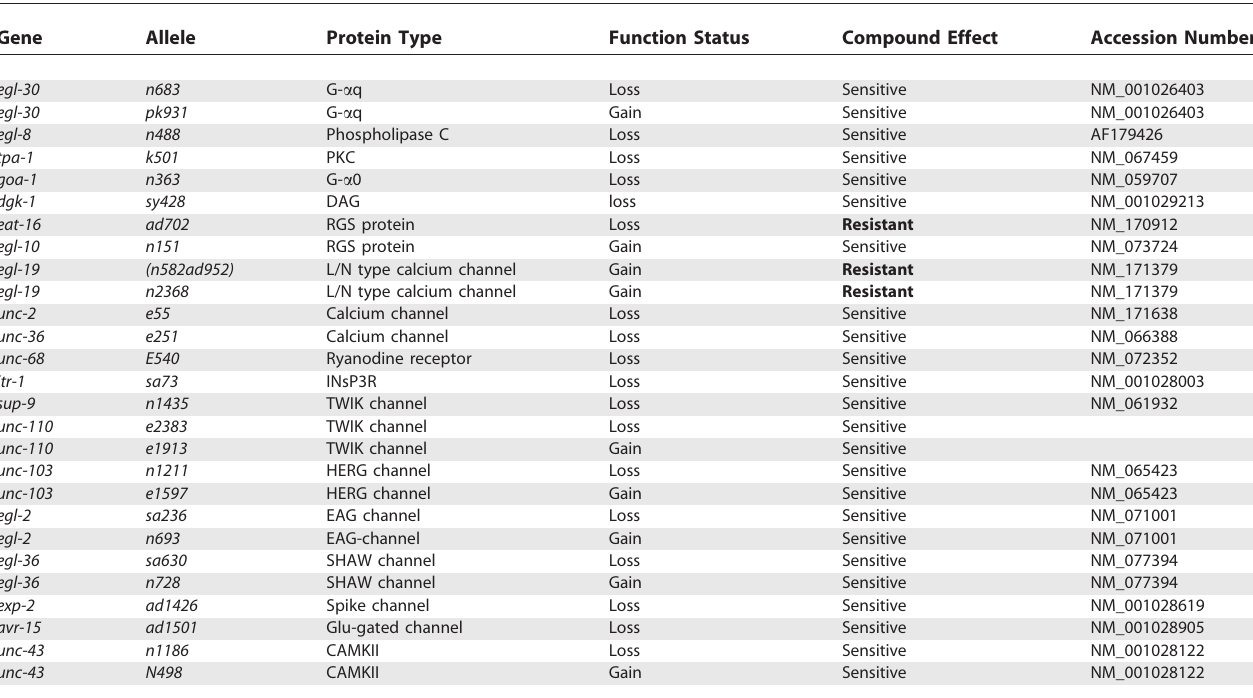
Spike channel ad1501 Glu-gated channel Loss Sensitive CAMKII Loss Sensitive CAMKII Gain Sensitive NM_001028122 Bolded items are the only resistant ones. DOI: 10.1371/journal.pgen.0020057.t001 PLoS Genetics |